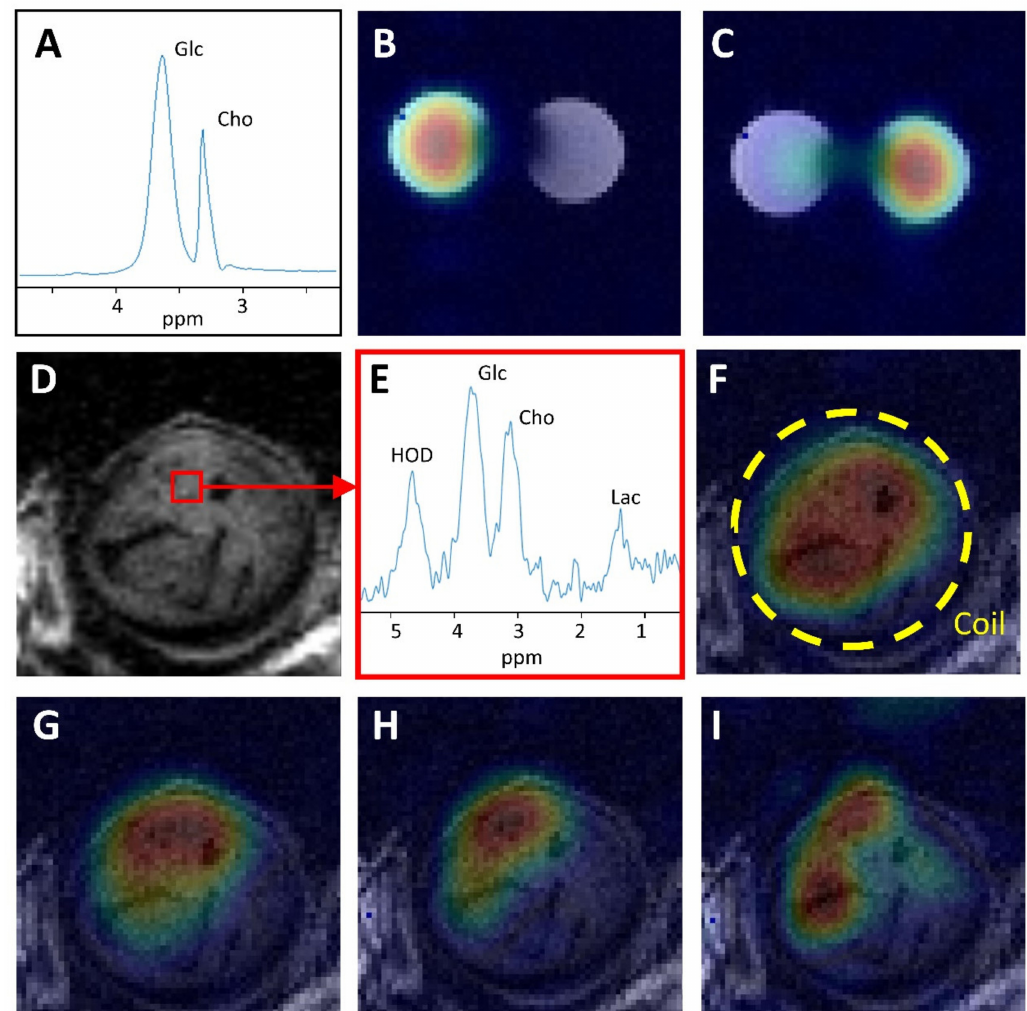
Figure 2. Deuterium metabolic imaging study of deuterated glucose and choline in phantom and in a human renal tumor subcutaneously growing in mice. ( A ). An unlocalized 2 H MR spectrum of two tubes, one filled with a saline solution of 2 H 9 choline (63 mM) and the other with a saline solution of [6,6 (cid:48) - 2 H 2 ]glucose (0.71 M). The glucose signal is completely separated from the choline signal. ( B ). [6.6 (cid:48) - 2 H 2 ]glucose map reconstructed from high resolution DMI of both tubes. ( C ). [ 2 H 9 ]choline map reconstructed from high resolution DMI of both tubes. ( D ). T2 weighted MR image of a slice through a NU12 renal carcinoma growing in the flank of an NSG mouse. A voxel of 8 µ L is indicated, which was selected from a high resolution 3D DMI recorded in 37 min after IV application of a mixture of [6,6 (cid:48) - 2 H 2 ]glucose and [ 2 H 9 ]choline. ( E ). The 2 H MR spectrum of the 8 µ L voxel selected from the tumor shows signals for water (HOD), glucose (Glc), choline (Cho) and lactate (Lac). The spectrum was filtered with a 2Hz exponential line broadening. The glucose and choline signals are clearly separated. ( F ). HOD map reconstructed from 3D DMI. ( G ). Glucose map reconstructed from 3D DMI. ( H ). Choline map reconstructed from 3D DMI. ( I ). Lactate map reconstructed from 3D DMI. The maps are oriented parallel to the 2 H RF coil (indicated by a circle in F) and projected on top of T1 MR images. The metabolic color maps were scaled to the highest intensity of the corresponding metabolite